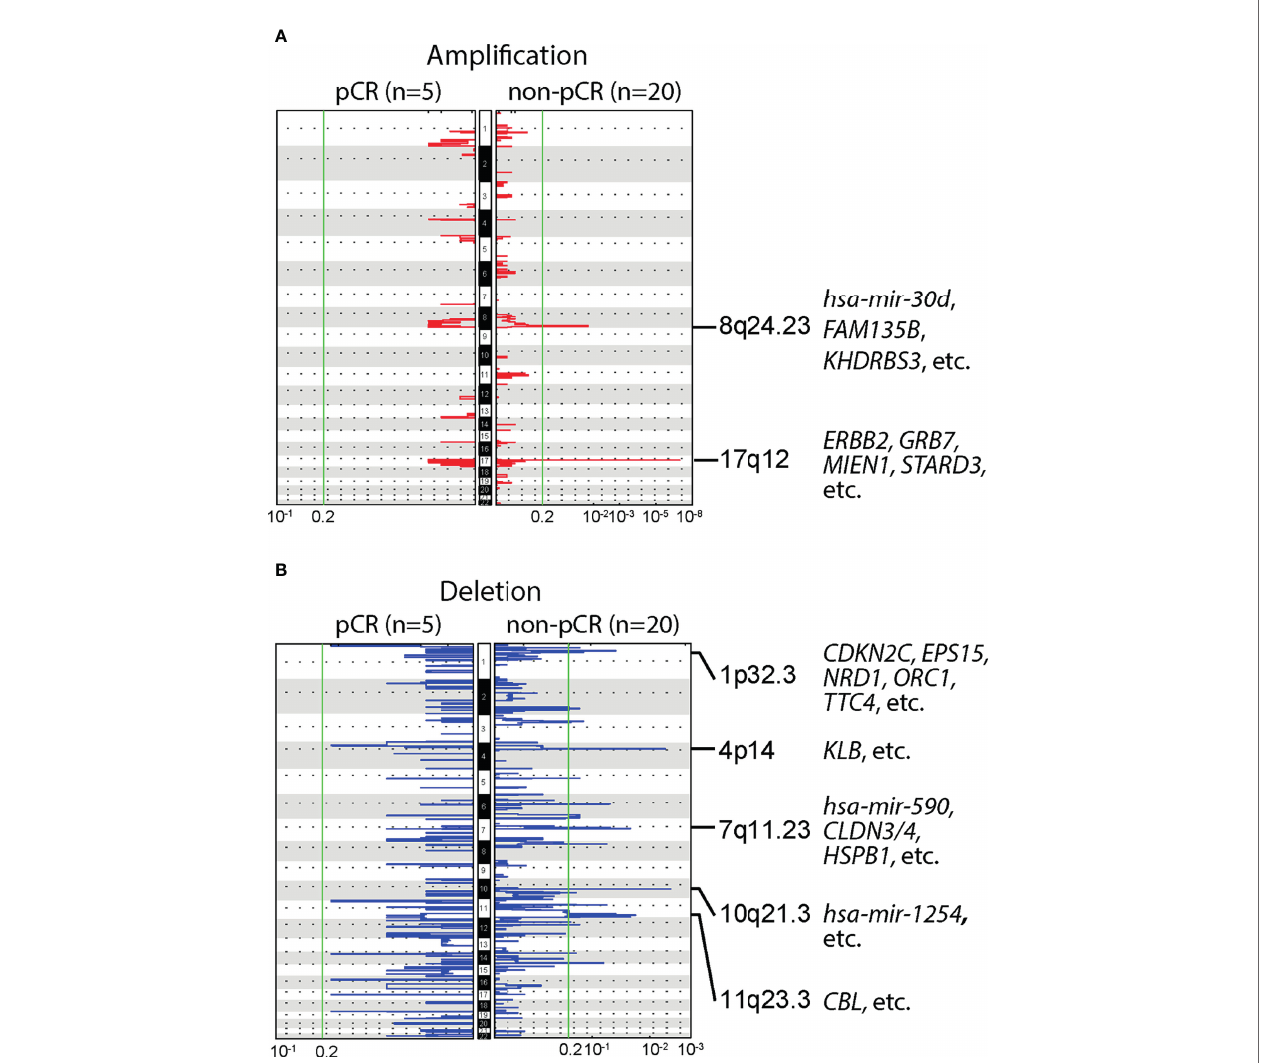
FIGURE 3 | Baseline arm-level copy number alterations (CNAs) and responses to neoadjuvant chemotherapy (NAC). (A) Signi fi cant ampli fi cations were detected in the chromosomal region 8q24.23 and 17q12, in patients not achieving pCR, but no signi fi cant ampli fi cations were observed in patients achieving pCR. Of note, ERBB2 , a gene closely related to breast cancer (BC) was located in 17q12. (B) Multiple signi fi cant deletions were detected in patients not achieving pCR, and fi ve regions with the highest q -values were 1p32.3, 4p14, 7q11.23,